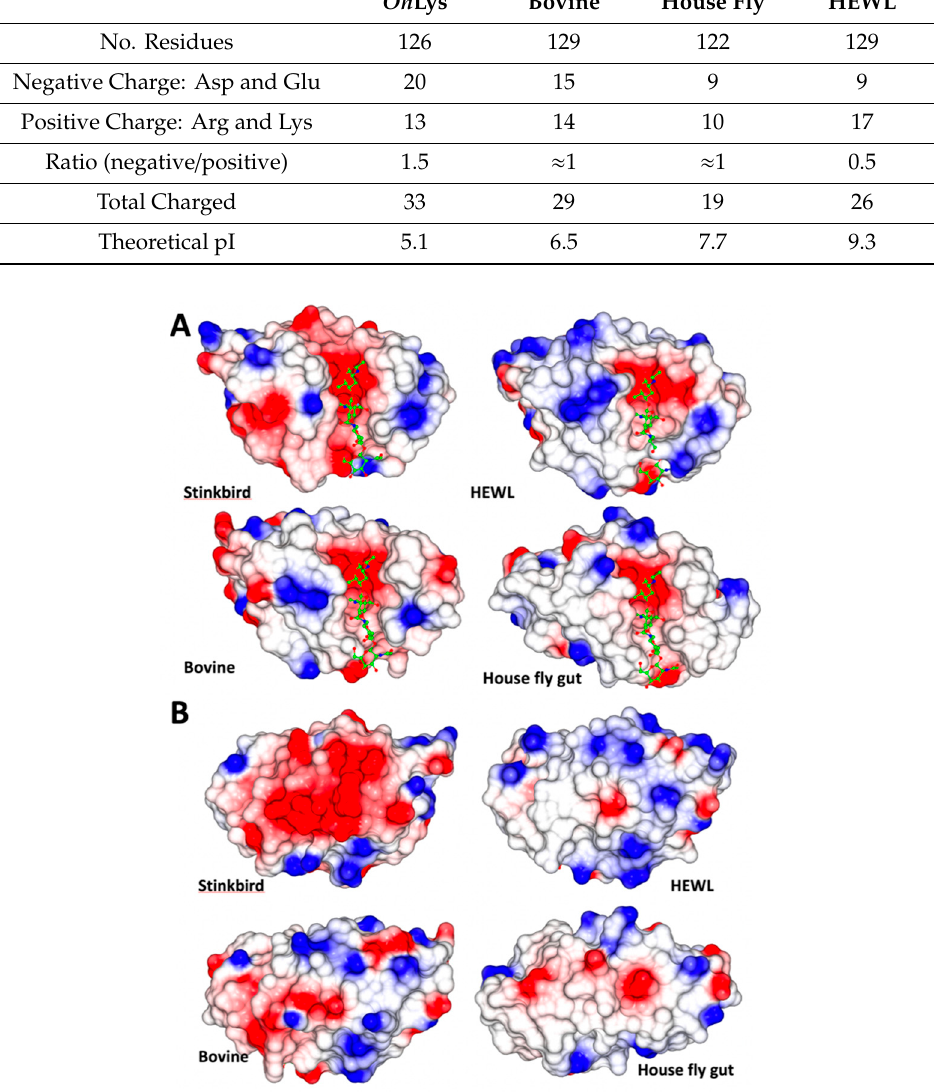
Figure 3. Electrostatic surface charge (red: negative and blue: positive) for Oh Lys, HEWL, Bovine gut lysozyme and house fly gut lysozyme, calculated at pH 7.0, within CCP4mg. ( A ) viewed from the active site side of the enzymes, ( B ) from the opposite side. The single clear observation is that the rear ( B ) of Oh Lys carries a substantially higher negative charge. The structures were superposed using the Gesamt option in CCP4mg. The ligand is taken from the Oh Lys complex.